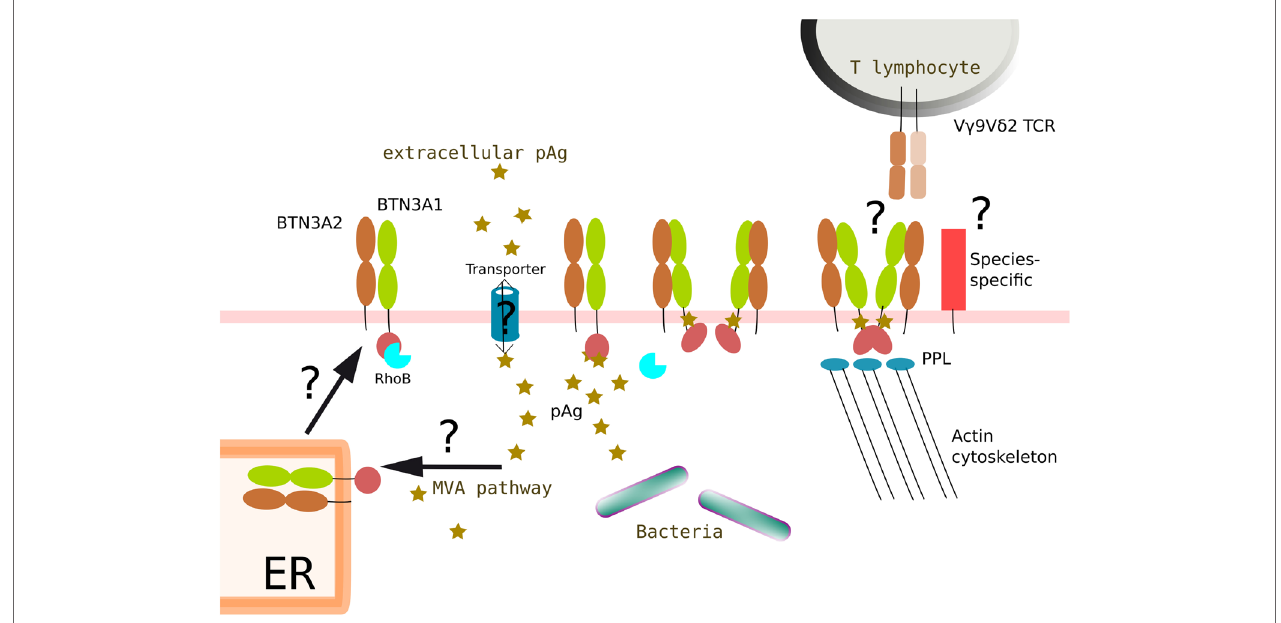
FiGURe 4 | Proposed integrated model of BTN3A1 modifications induced by phosphoantigens and leading to the antigenic activation of V γ 9V δ 2 T lymphocytes. Intracellular accumulation of pAg could originate from a dysregulation of the Self mevalonate (MVA) pathway in pathological situations (e.g., cancer, infections) and/or be from exogenous origin (e.g., pathogens). In some situations, negatively charged pAg would need to be routed (e.g., import/export) via active processes (e.g., ABC transporters). pAg would then bind to intracellular parts of butyrophilin molecules (e.g., B30.2 ± juxtamembrane domains) at different sub-cellular locations during synthesis and routing steps of the molecules (e.g., ER, cell membrane). The binding of pAg to butyrophilins induces structural modifications that affect the dynamics of the molecules (e.g., membrane diffusion) and the immunological visibility of these molecules. Accordingly, the transition from resting to activatory state of these molecular complexes might also be linked to the nature of the multimerization of BTN3A1 glycoproteins (e.g., homodimers, heterodimers). The contribution of additional partner molecules, some of them being species-specific, regulating actin cytoskeleton modifications (e.g., RhoB, PPL) might also be important. The mechanisms that drive this unique antigenic activation process of human V γ 9V δ 2 T lymphocytes sensing these subtle molecular changes though a specific, contact-, and V γ 9V δ 2 TCR-dependent process remain a major conundrum. The question marks (?) refer to unsolved or yet unclear